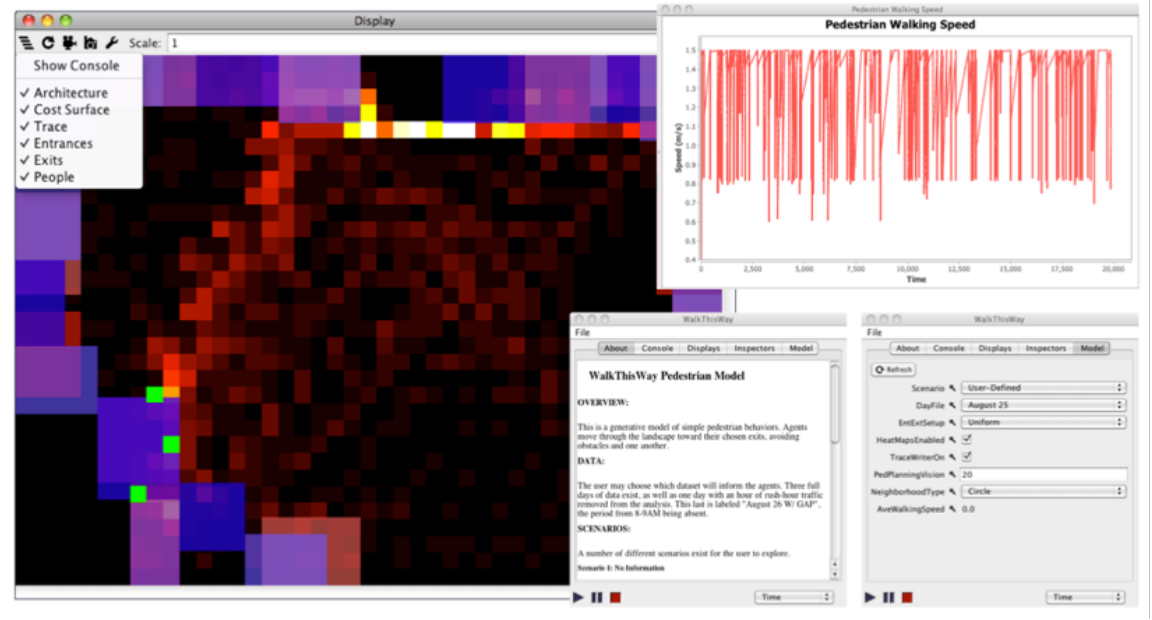
Figure 3. Graphical user interface of the SA 2 -ABM